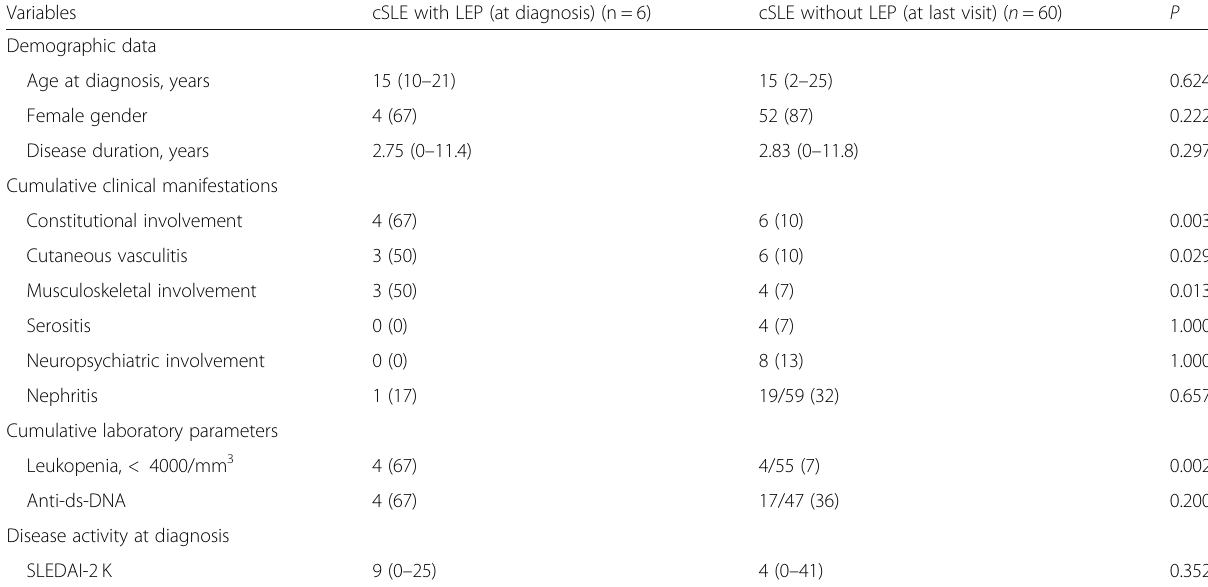
Table 2 Demographic data, cumulative clinical manifestations and laboratory parameters, and SLEDAI-2 K in childhood-onset systemic lupus erythematosous (cSLE) patients with lupus erythematosus panniculitis